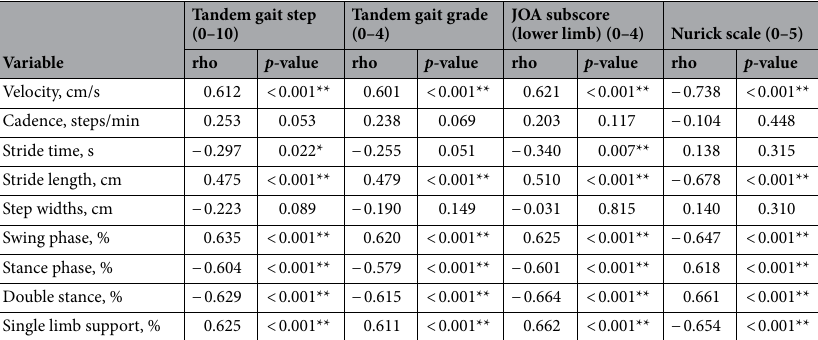
Table 3. Results of correlation analyses between gait parameters and tandem gait step/grade, JOA subscore and Nurick scale. *p < 0.05, **p < 0.01. rho = Spearman’s correlation coefficient. JOA Japanese Orthopedic Association.